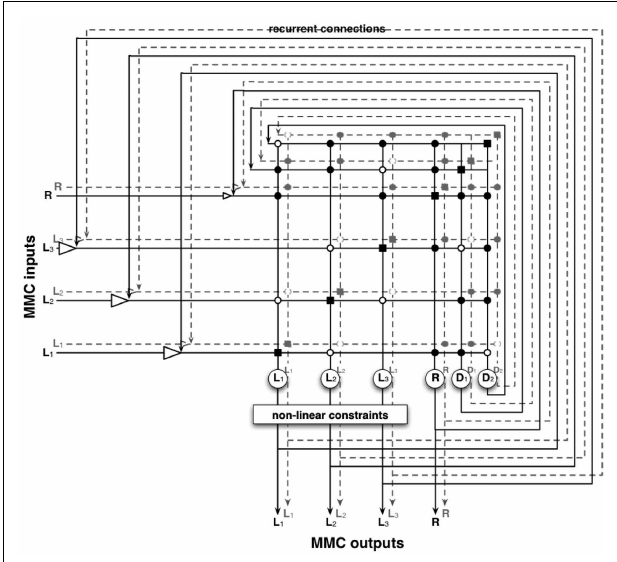
FIGUREA1 |The recurrent neural network consisting of 2 × 6 units. The network is composed of two identical networks (The one for the x -components is shown with black lines and the other for the y -components of the vectors is shown with the dashed lines).The units represent the components of the six vectors L 1 , L 2 , L 3 , D 1 , D 2 , and R of the manipulator.When an input is given, the corresponding recurrent channel is suppressed (symbolized by the open arrow